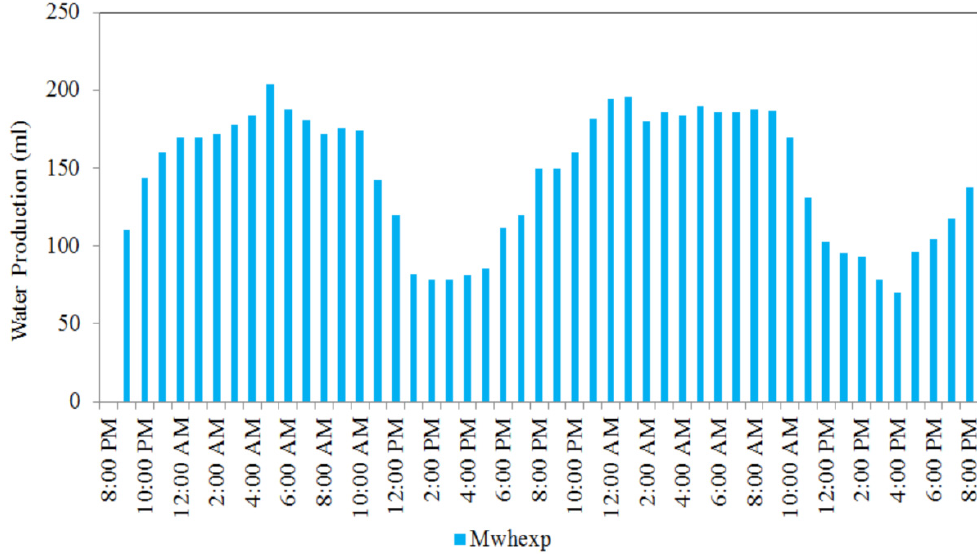
Figure 14. Values of hourly water production of MSAWG in a 48 h period from 8.00 p.m. on 18